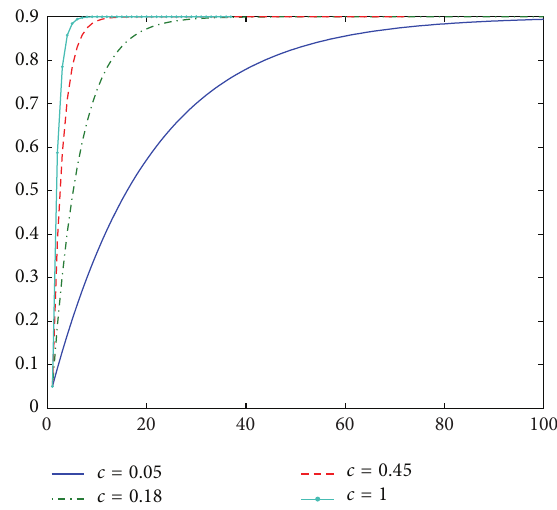
Figure 3: Memory effects function when 𝑝 2 = 0.1 , 𝑝(1) = 0.1 .